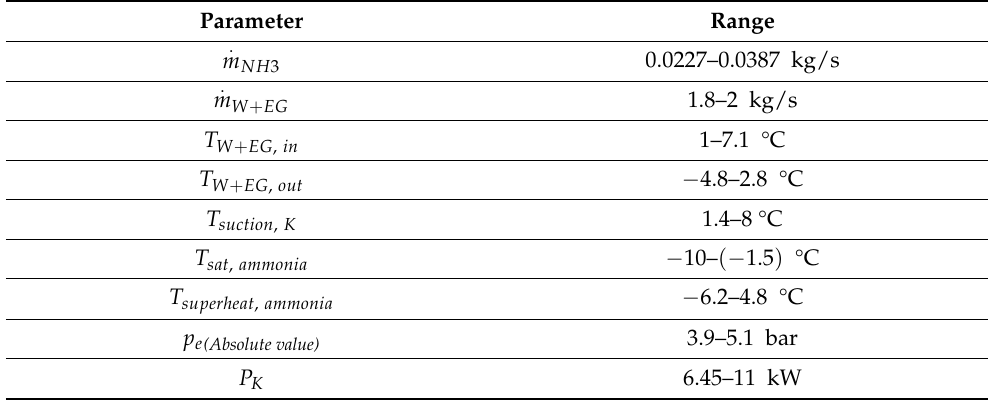
Table 3. Variation intervals for measured